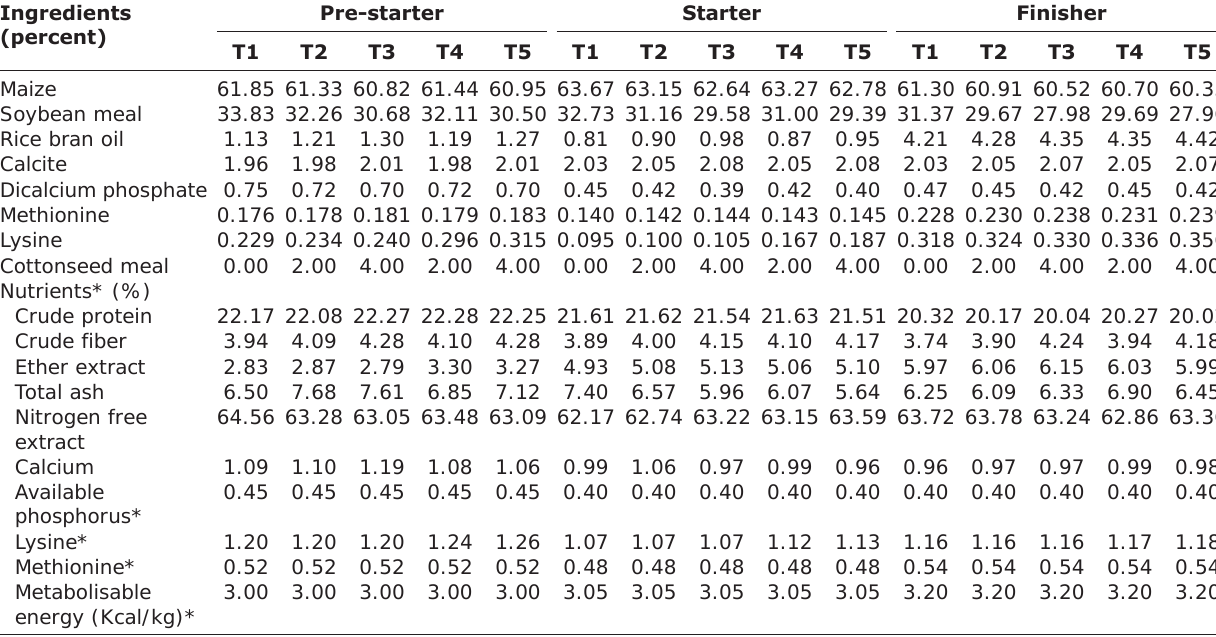
Table-2: Ingredients (as such basis) and nutrients composition (percent DM) of broiler pre-starter, starter, and finisher diet. Ingredients